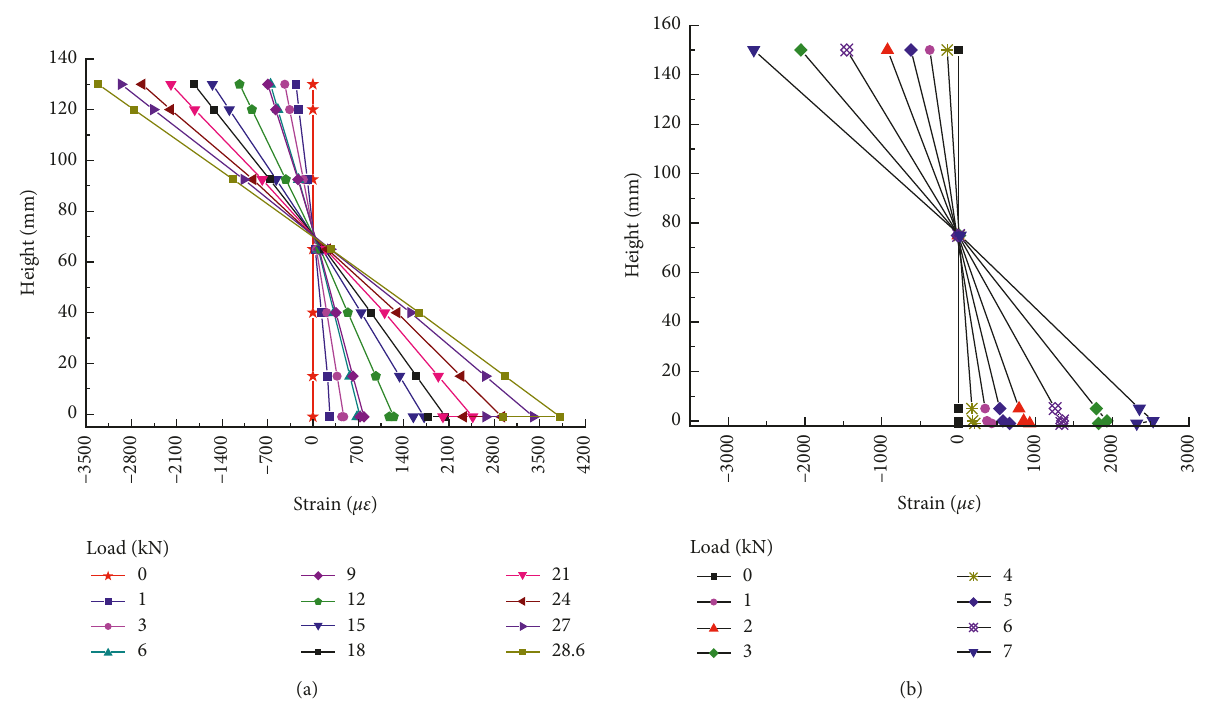
Figure 11: The load-strain curve of specimen section in the middle of the span. (a) AU-T beam. (b) SU-OT beam (mm).